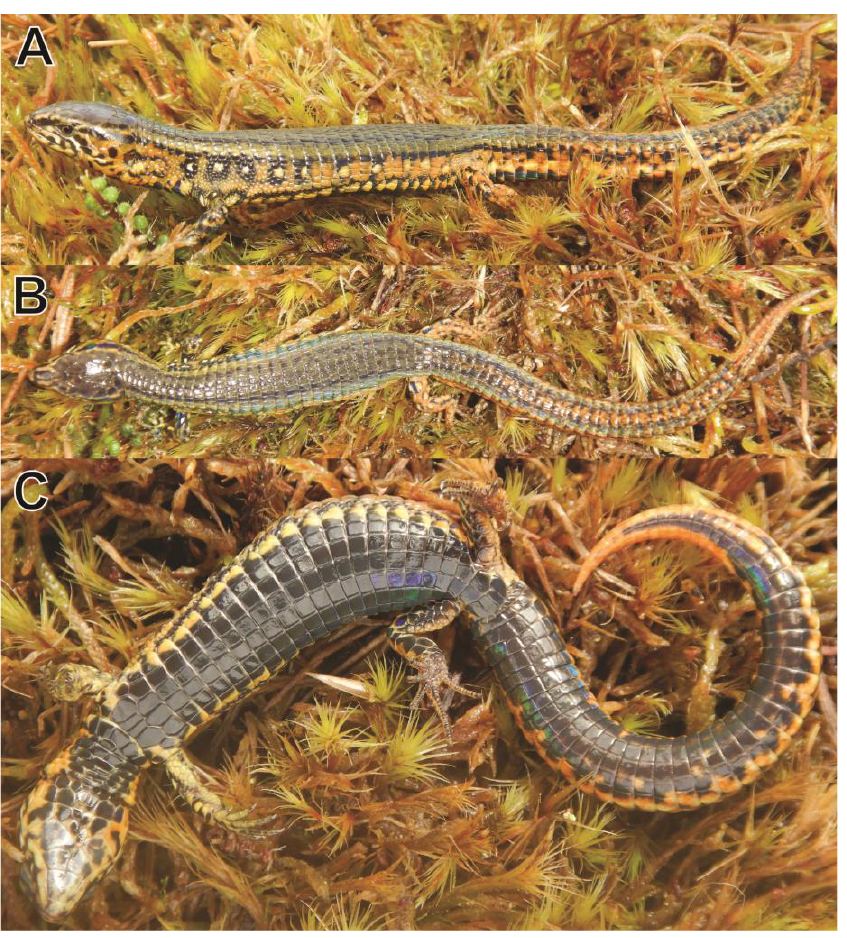
Figure 4. Life holotype of Proctoporus titans sp. nov. (MUSM 40916) in dorsolateral ( A ), dorsal ( B ), and ventral views ( C ). SVL 53.9 mm.